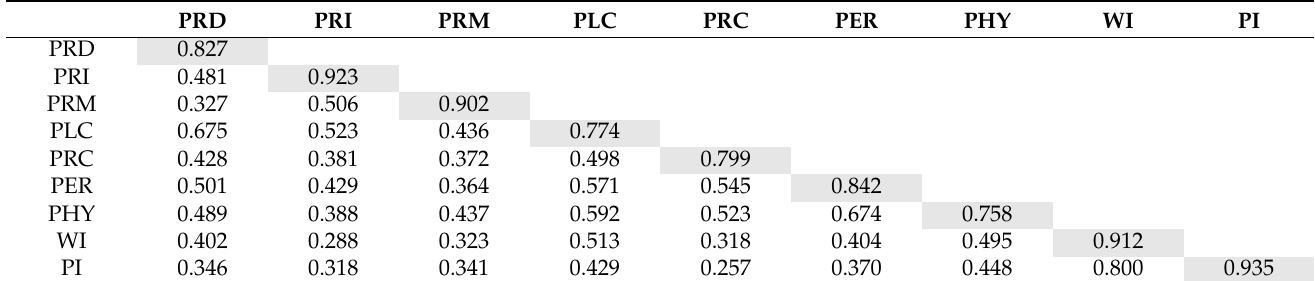
Table 3. Descriptive and bivariate correlations between main constructs, and square roots of average variance extracted